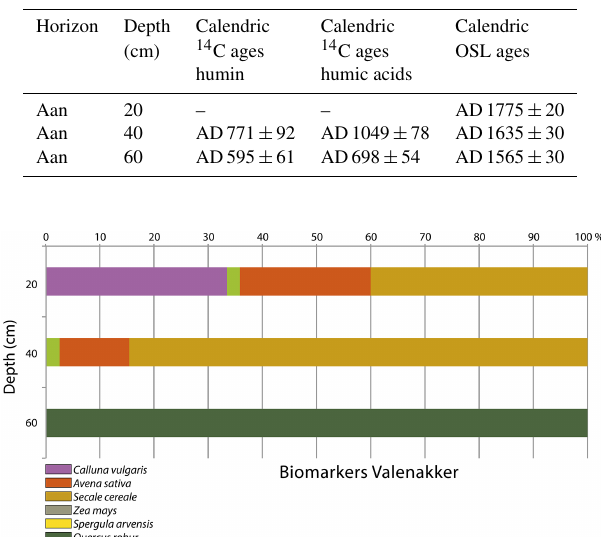
pollen spectra is complex: it is a mix of the regular pollen influx of plants on the fields and in the surrounding areas in- filtrating into the soil and pollen, and also the pollen present in various stable